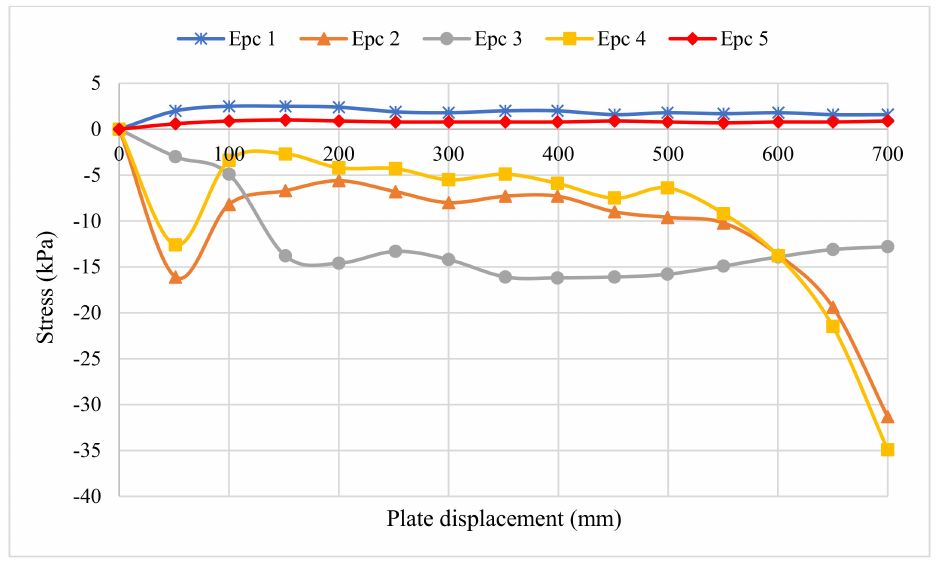
Figure 5. Stress values on the buried pipe at different